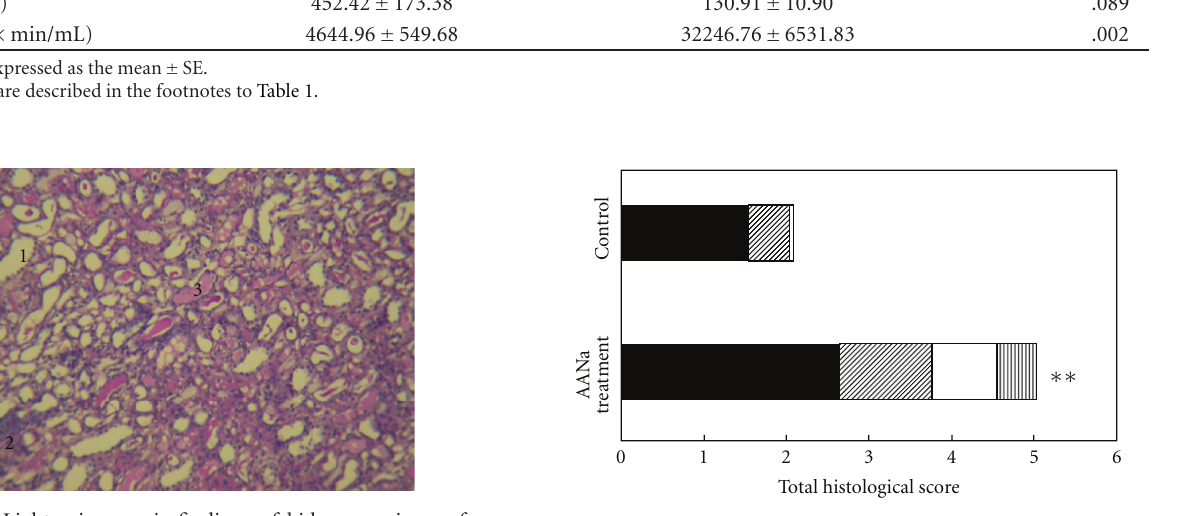
Figure 3: Light microscopic findings of kidney specimens from rabbits after treatment with 0.5mg/kg aristolochic acid sodium (AANa). The renal histology changed 7 days after 0.5mg/kg AANa iv administration. (PAS stain, magnification × 100). (1) Degener- ation of tubular epithelium; (2) mononuclear cell infiltration; (3) existence of hyaline cylinders.